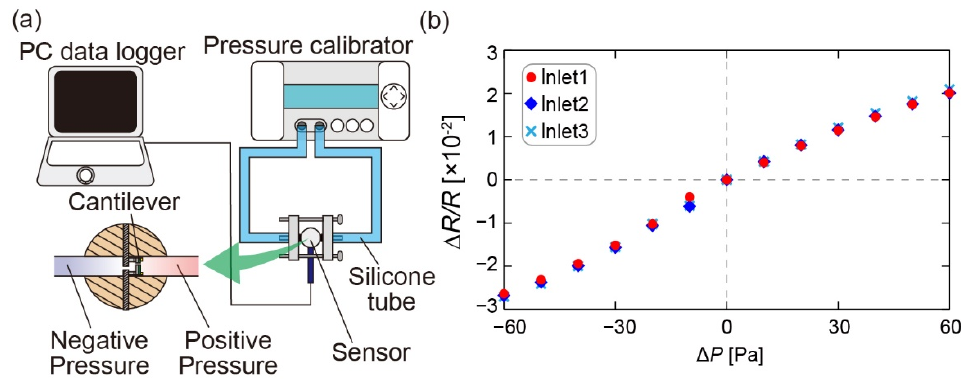
Figure 6. ( a ) Concept of the experimental setup for pressure calibration of the MEMS DP sensor chip built inside the sensor. ( b ) Relationship between the fractional resistance changes and the DP.